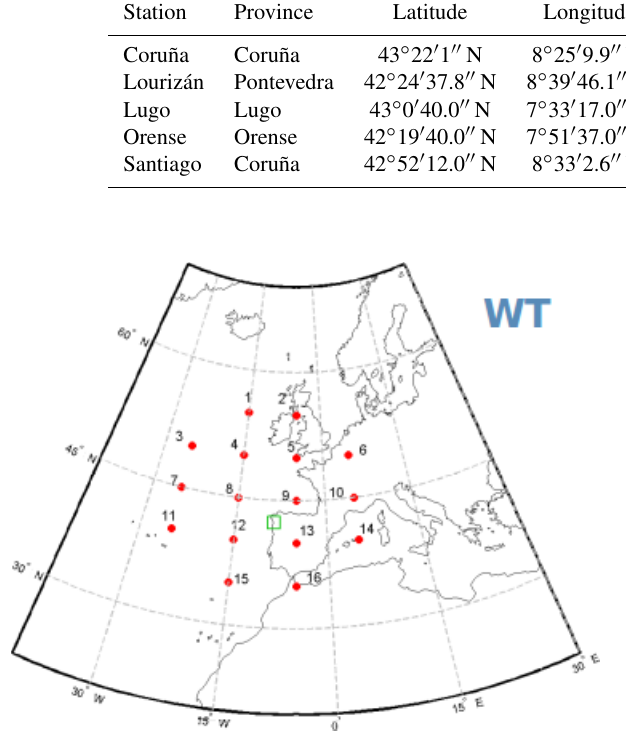
Figure A1. Pressure grid points used in the characterization of the